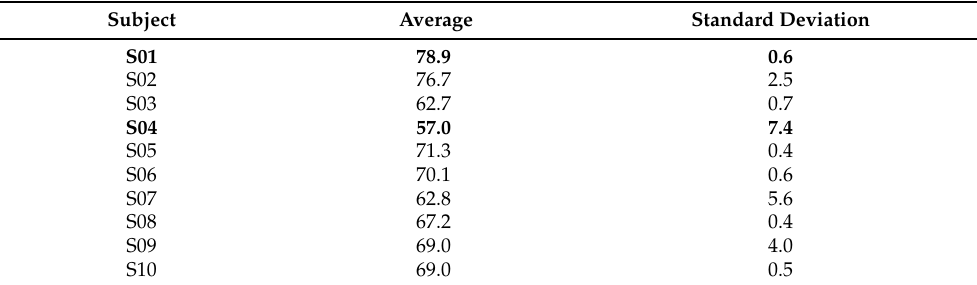
Table 5. Average classification accuracy (expressed in percentage) for the audio model trained to classify the performance of the AR models of the ten subjects that participated within the data collections of InSync dataset.